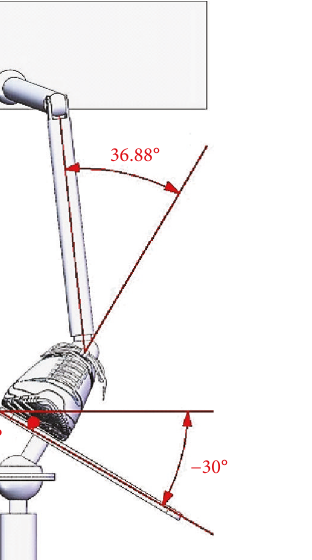
Figure 10: Limit posture of the ankle joint for the valgus motion ( β min = − 30 ° ).